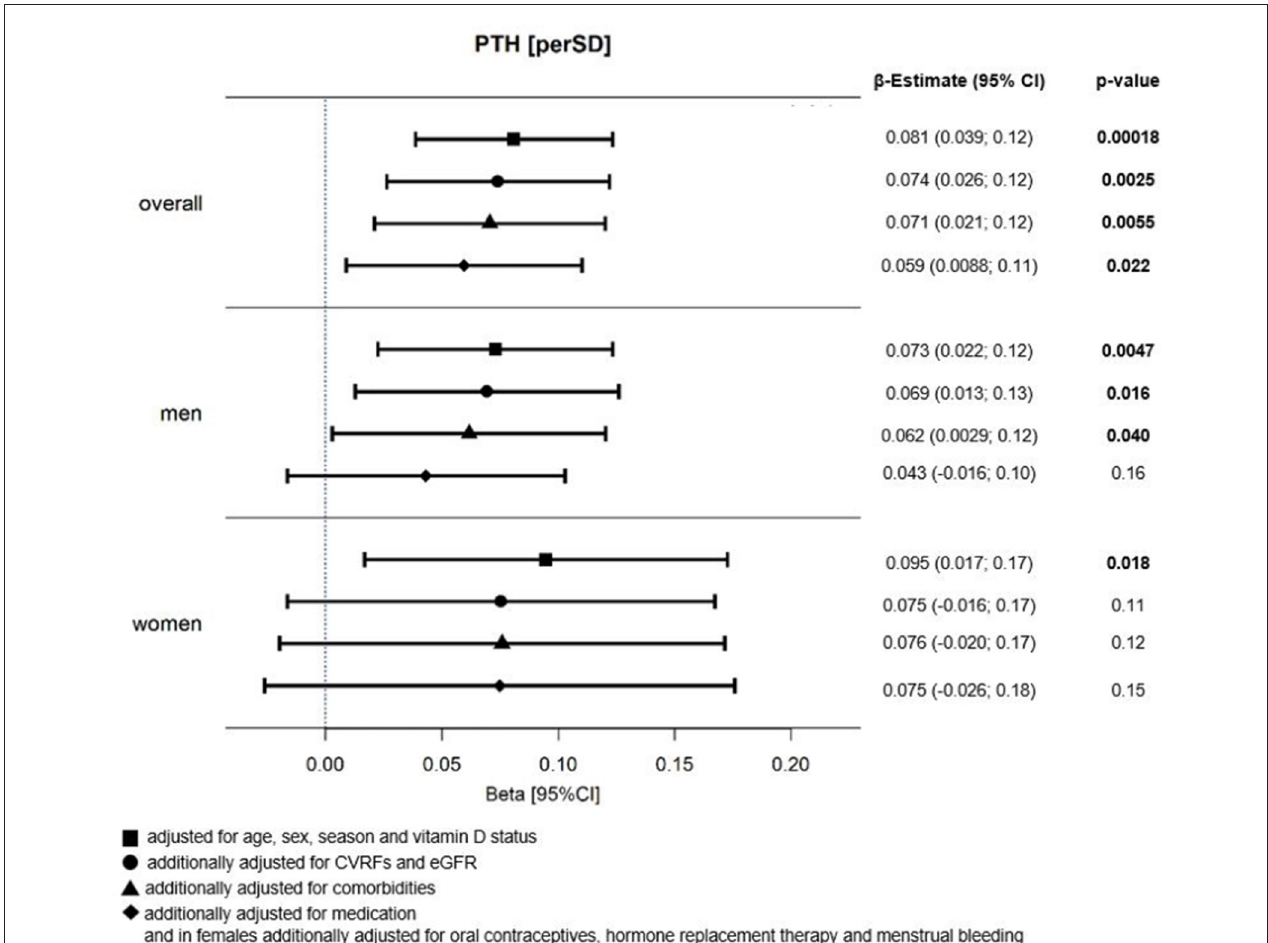
FIGURE 2 | Relation between MPV and PTH in HF individuals. Forest Plot of beta ( β )-estimates with 95% confidence intervals (CIs) for the relation between MPV and PTH in all HF individuals and stratified by sex. N = 1,861; thereof N = 532 females and N = 1,329 males; adjustment for sex only in overall analysis sample; MPV, mean platelet volume; PTH, parathyroid hormone; CVRFs, cardiovascular risk factors; eGFR, estimated glomerular filtration